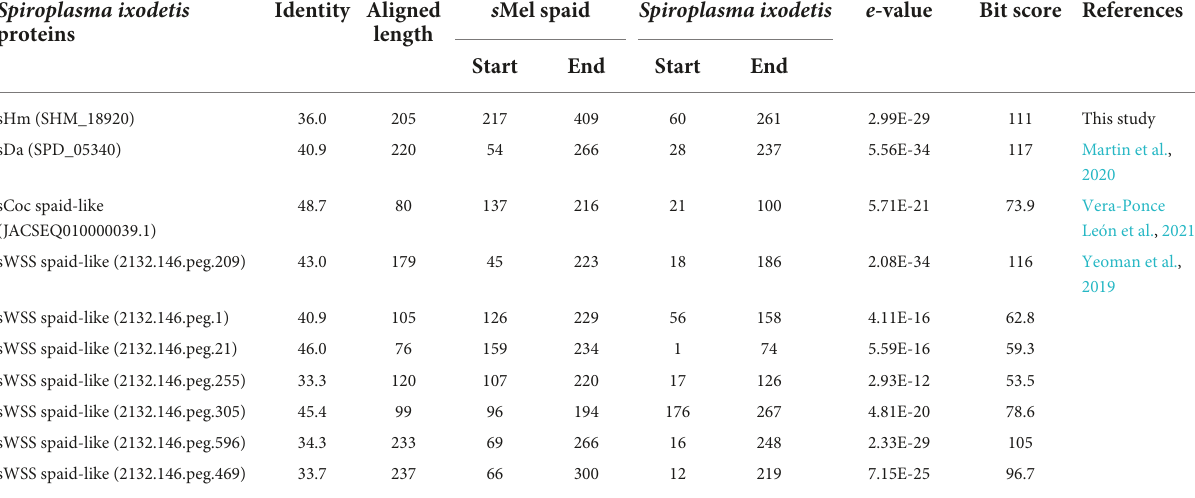
TABLE 3 Homology between Spaid [1,065 aa] of strain s Mel and proteins of Spiroplasma ixodetis strains based on BLASTp search. Spiroplasma ixodetis